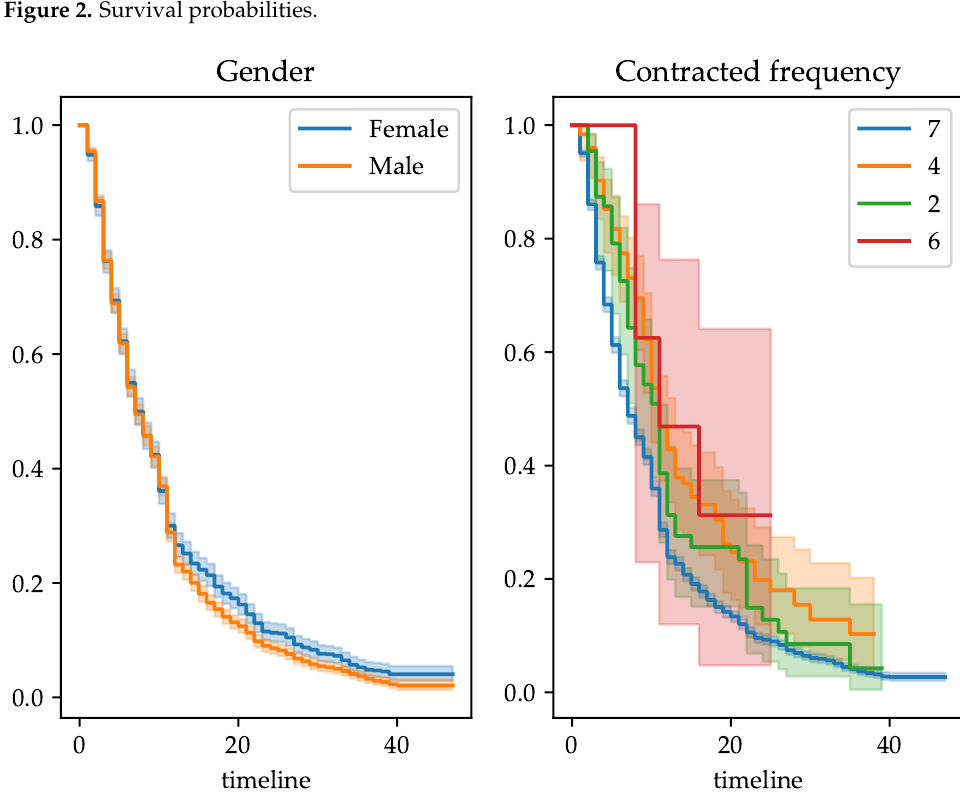
Figure 3. Survival by gender and contracted access